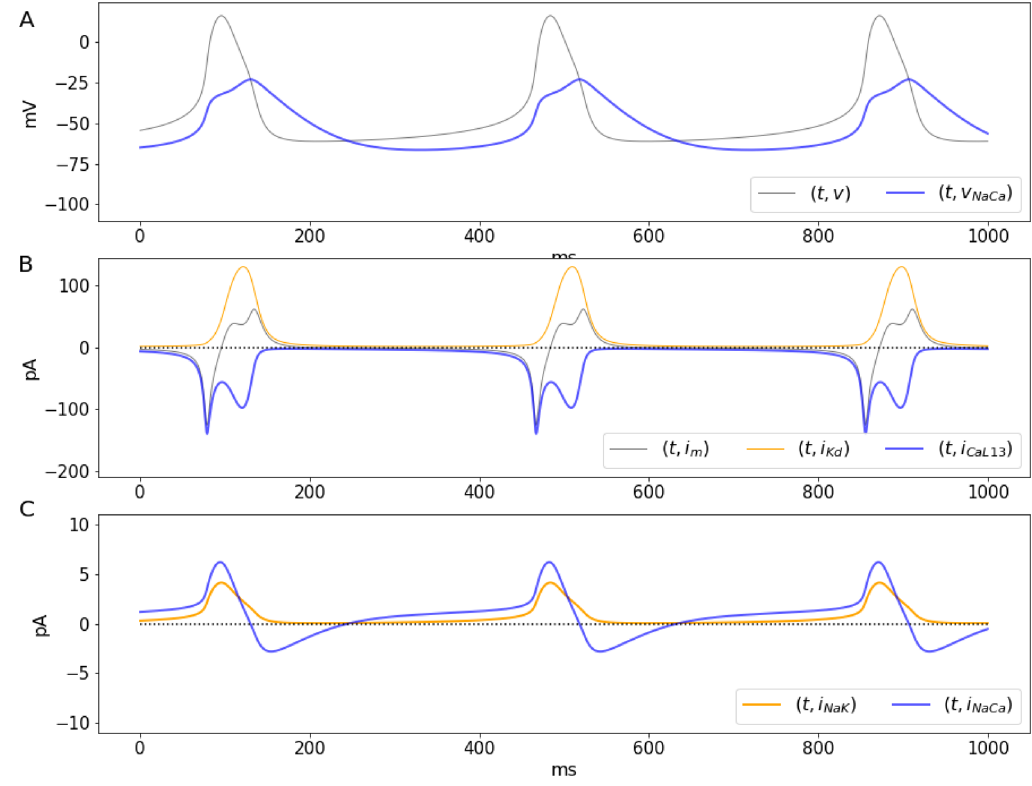
Figure 4. Central sinoatrial node pacemaking dynamics using the system (35)–(42). A . Transmembrane potential (gray) and the reversal potential v (blue) as a function of time. B . Dynamics of large calcium (blue) and potassium (orange) currents in pA. The total NaCa current shown by a gray line labelled as i . C . Currents mediated by NaK ATPases (orange) and Na-Ca exchangers (blue), respectively. Notice m the carrier mediated currents ( C ) are about one order of magnitude smaller than those mediated by channels shown ( B